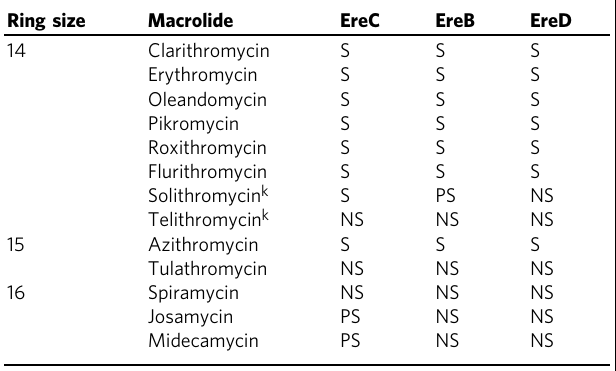
Table 1 Activity of erythromycin esterases against a panel of